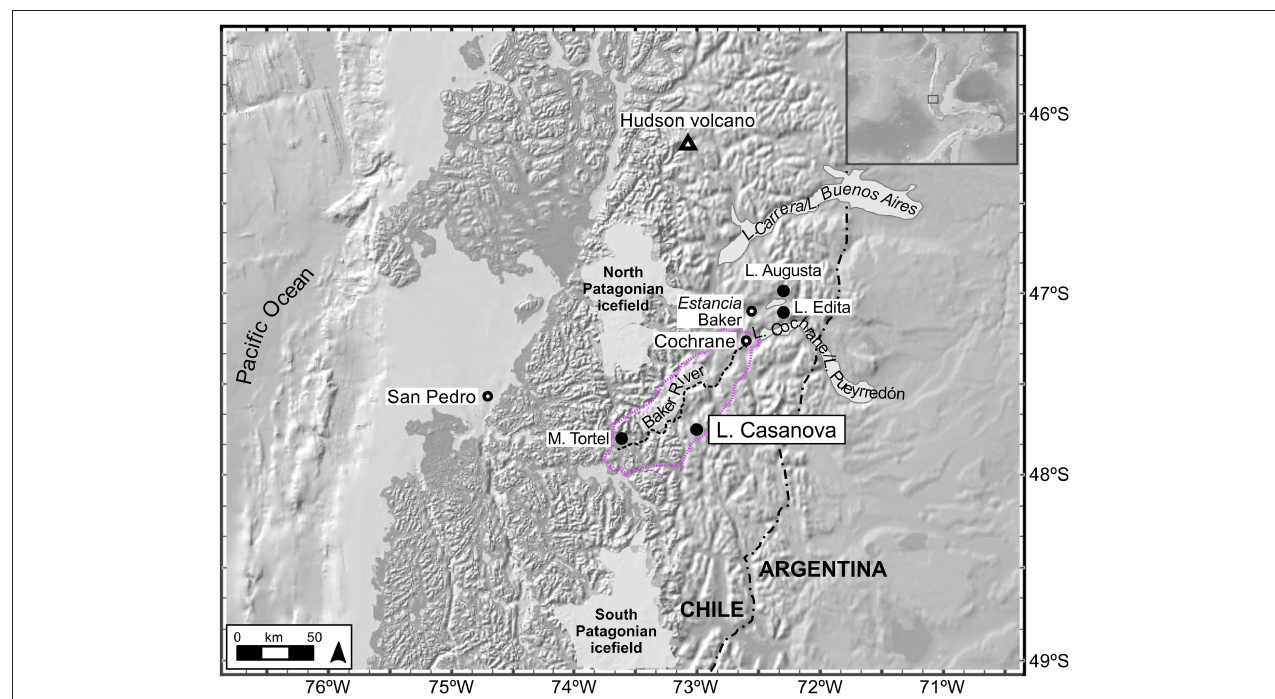
FIGURE 1 | Study area and location of L. Casanova and other sites mentioned in the manuscript. M. Casanova is the ombrotrophic Sphagnum bog surrounding the lake. The coring site is located southeast of L. Casanova. The approximate boundaries of the Baker River watershed are shown in color.